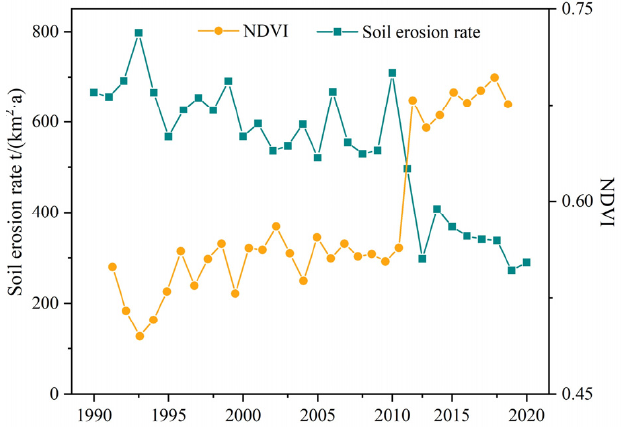
Figure 8. Historical changes in soil erosion rate and the NDVI in GPRB and its sub-basins in the past 30 years.